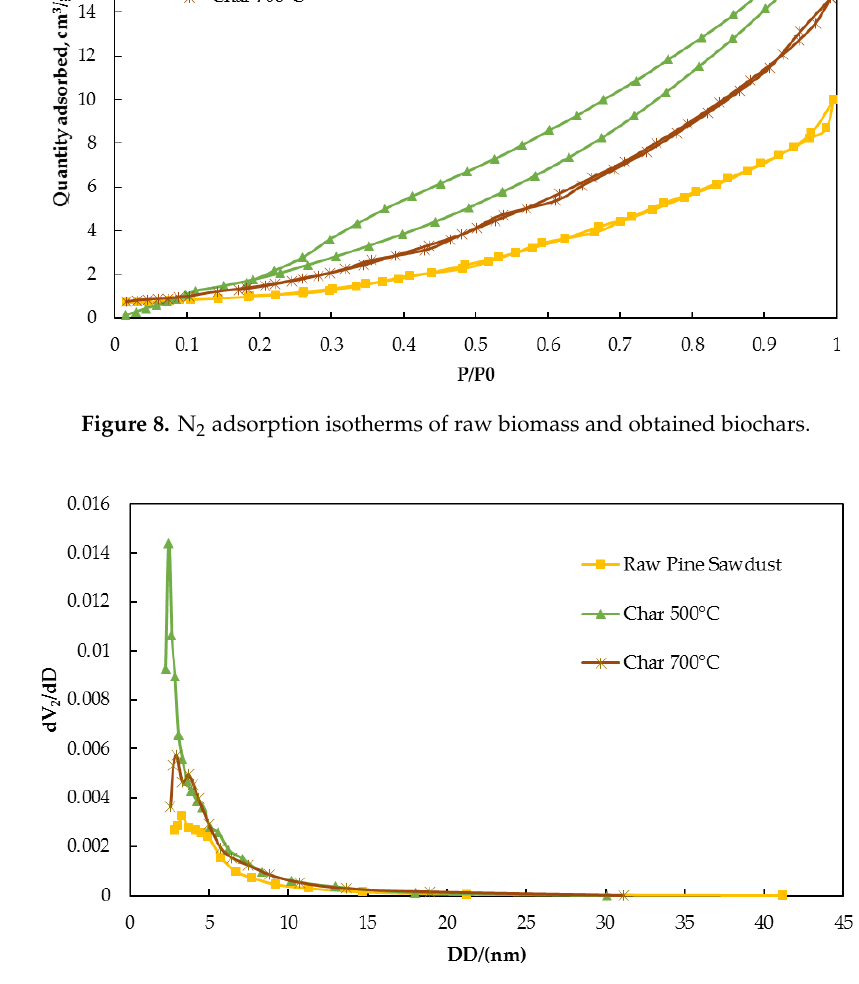
Figure 9. Pore size distribution calculated from the BJH (Barret, Joyner, and Halend) adsorption branch of raw biomass and obtained biochars.